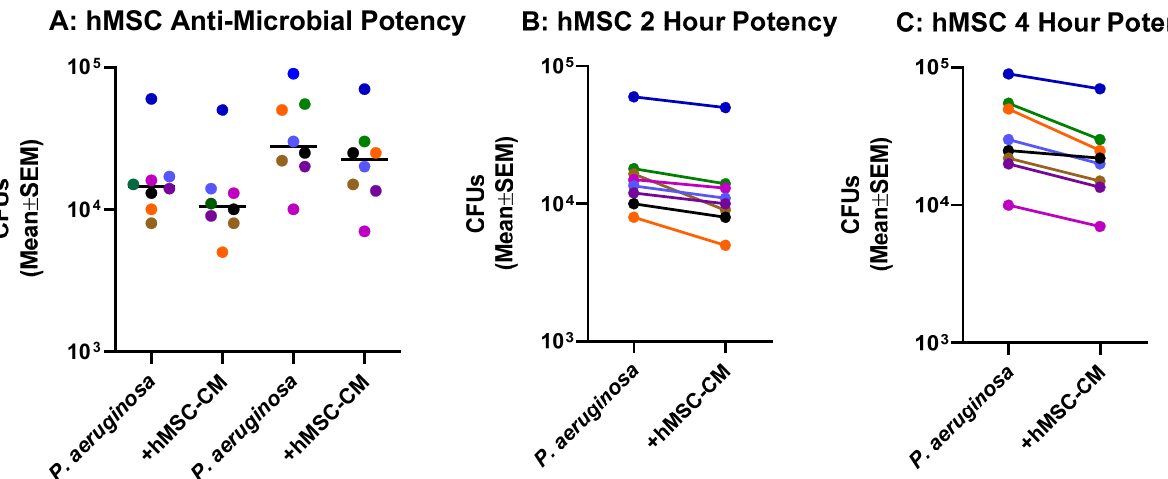
Figure 3. hMSC Anti- P. aeruginosa Potency Screen. Each of the hMSC-conditioned medium prepa- rations generated without antibiotics were analyzed for antimicrobial potency against Pseudomonas aeruginosa . The hMSC-conditioned medium from each of the donors (shown by a different color) had antimicrobial potency ( A ). When each hMSC-conditioned medium preparations were analyzed individually for antimicrobial potency measuring CFUs at 2 h ( B , n = 8) and 4 h ( C , n = 8).